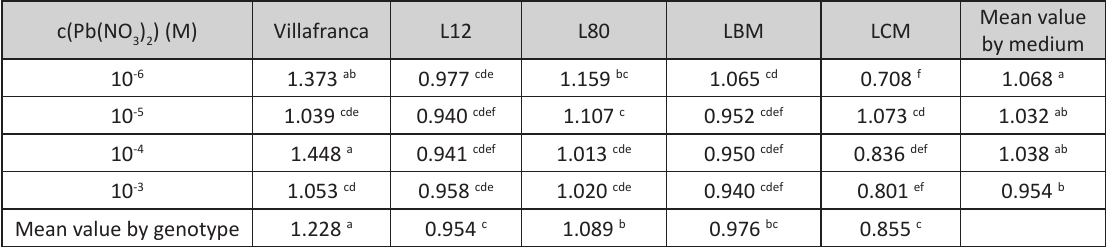
1) Labels for F-test: * - significant at the level α=0.05; ** - significant at the level α=0.01 The effect of lead concentration in medium on the tolerance index for Chl a/b ratio in white poplar genotypes (LSD –